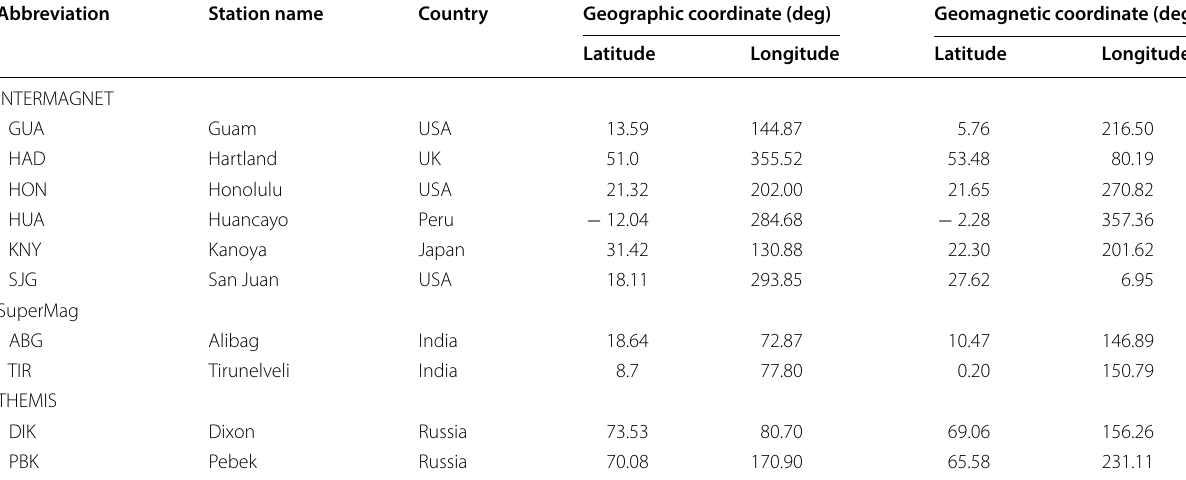
Table 2 List of the INTERMAGNET, SuperMAG, and THEMIS magnetometer stations